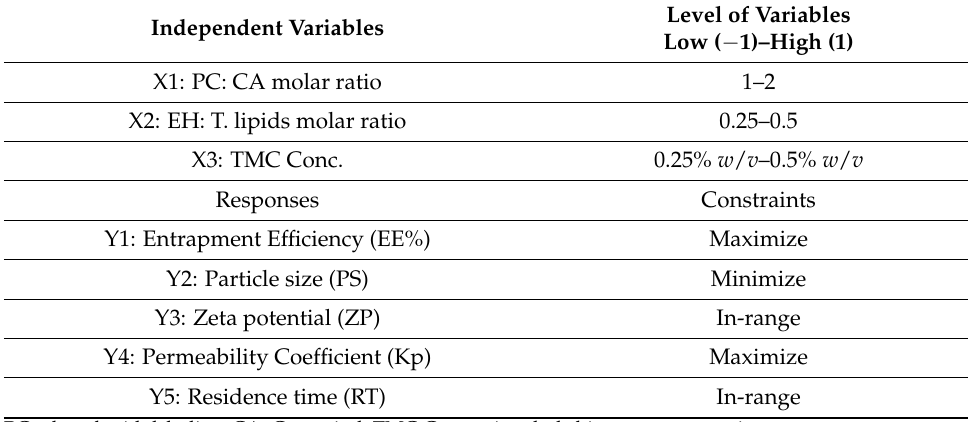
Table 1. Full experimental (2 3 ) factorial design parameters and constraints.